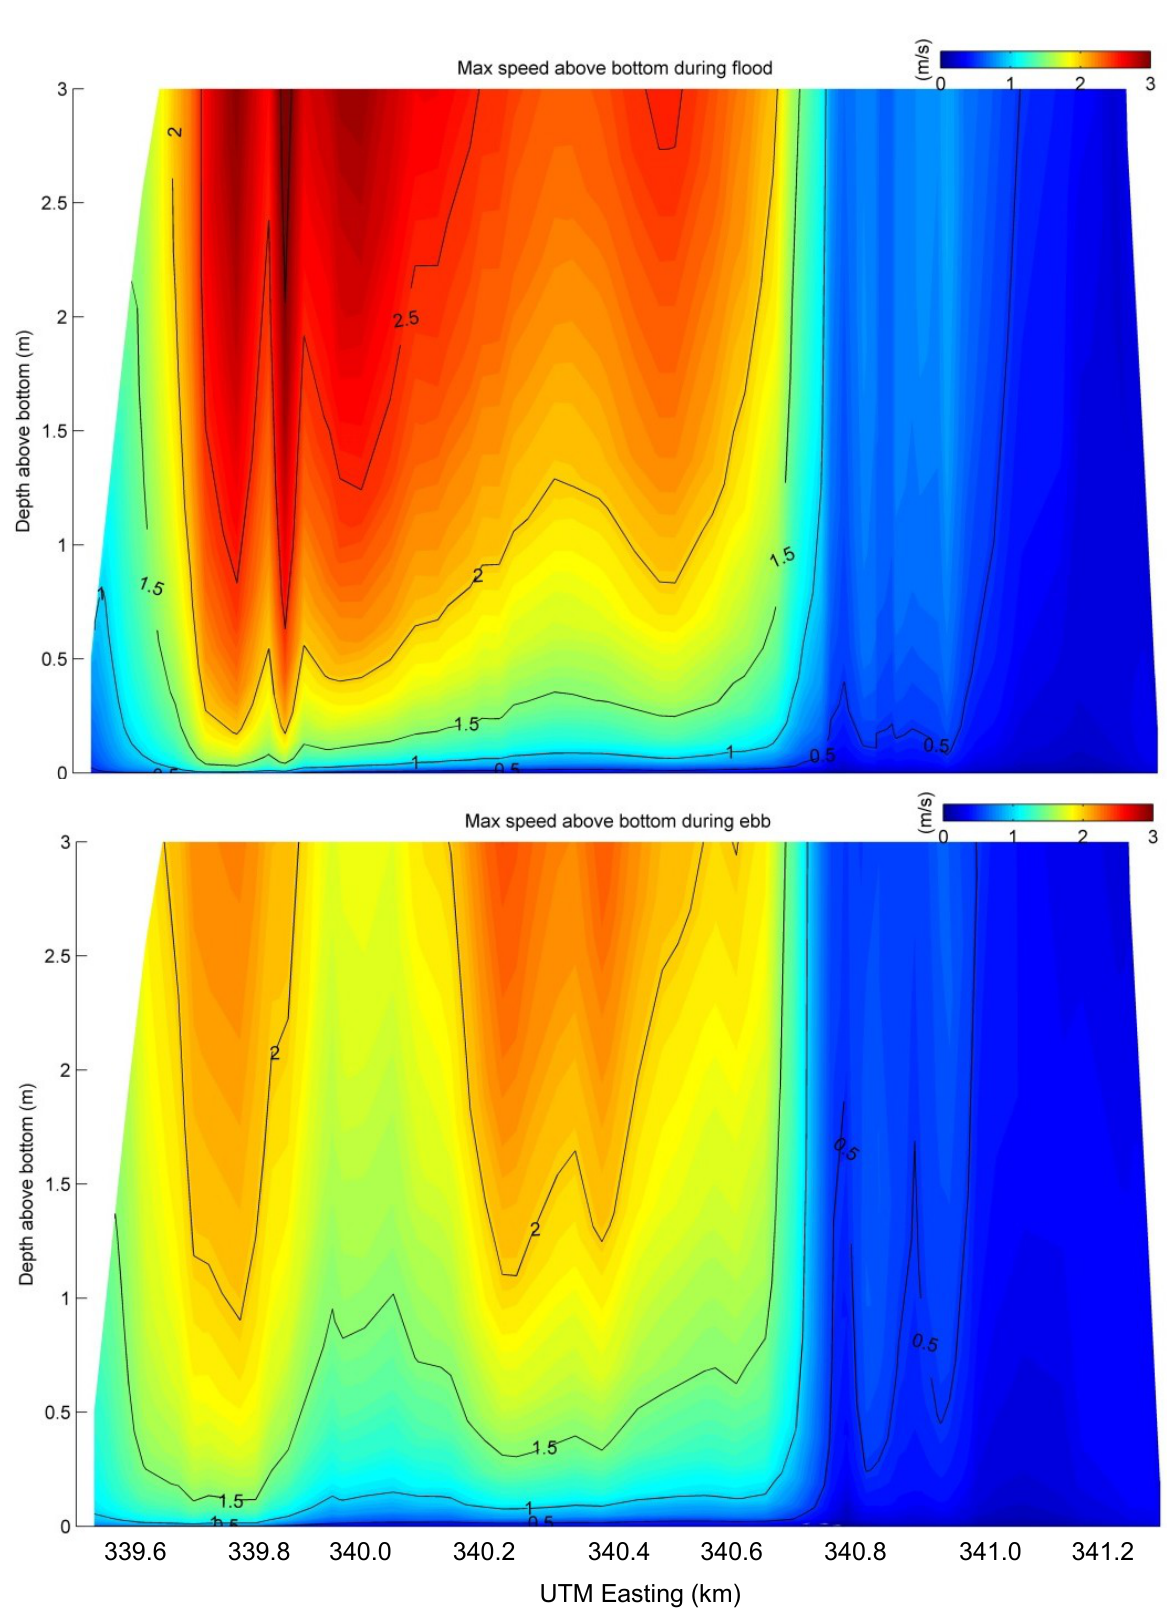
Figure 10. Near bottom vertical distribution of model produced maximum current speeds along the routes during flood (upper panel) and ebb (bottom panel)